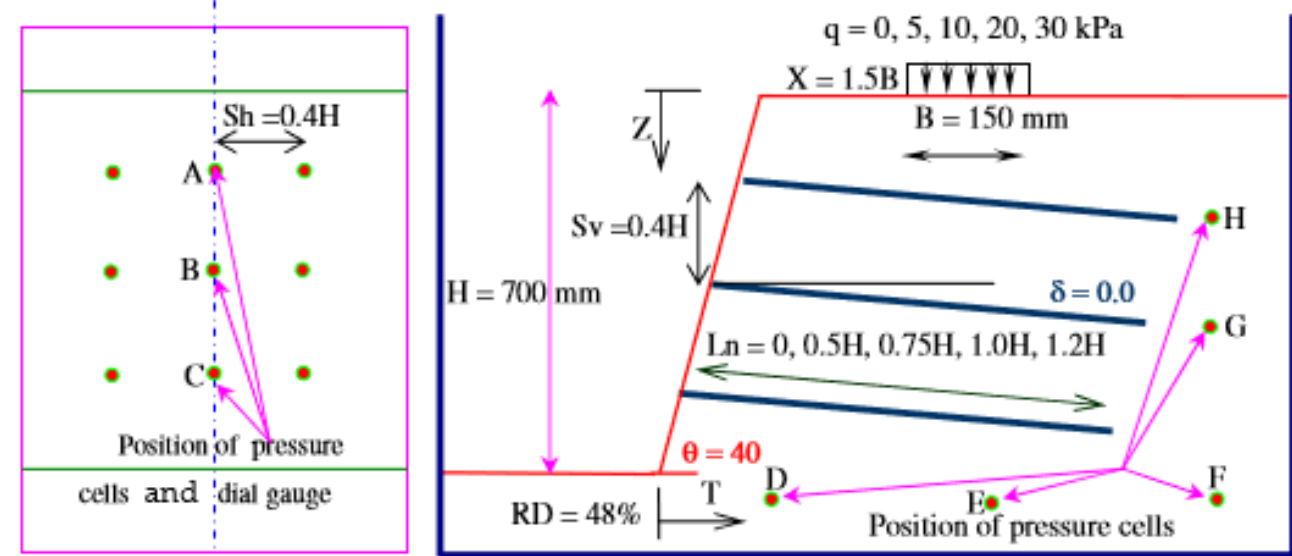
Figure 4. Experimental models with different nail parameters. H—Excavation height; B—Footing width; Sv—Nail vertical spacing; Sh—Nail horizontal spacing; Ln—Nail length; q—Surcharge; δ —Inclination of the nail; X—Distance of footing from crest; θ —Slope angle; RD—Relative density of the sand.